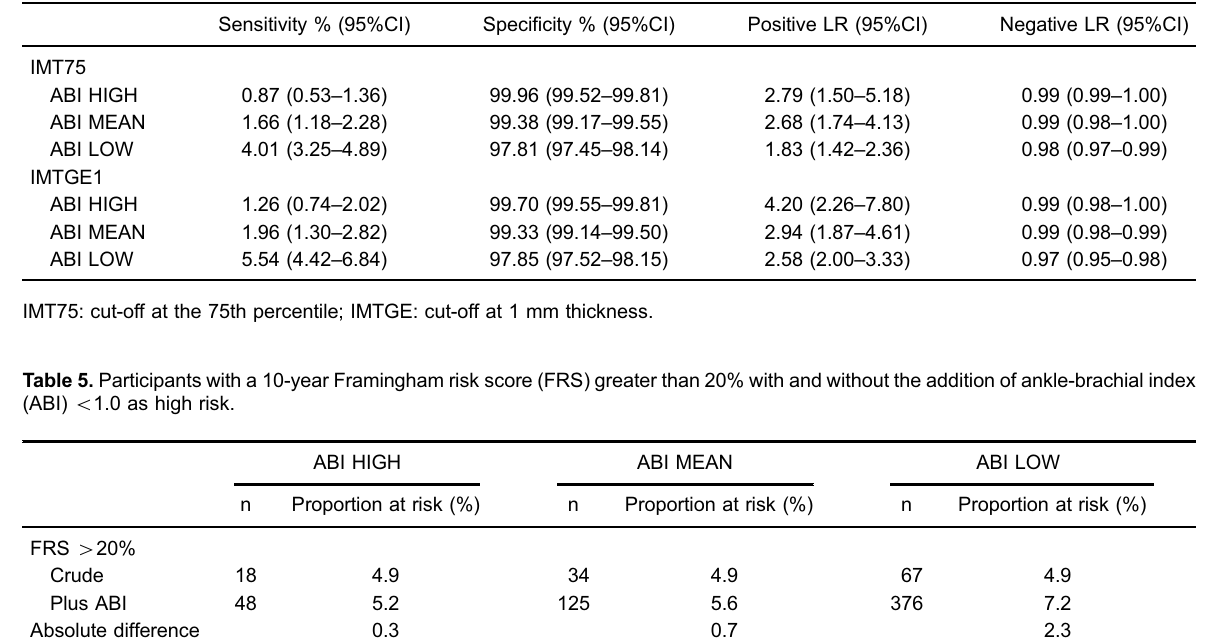
Table 4. Sensitivity, speci fi city, positive and negative likelihood ratios (LR), and 95% con fi dence intervals for each category of ankle- brachial index (ABI), using common carotid artery intima-media thickness (IMT) as a gold standard.